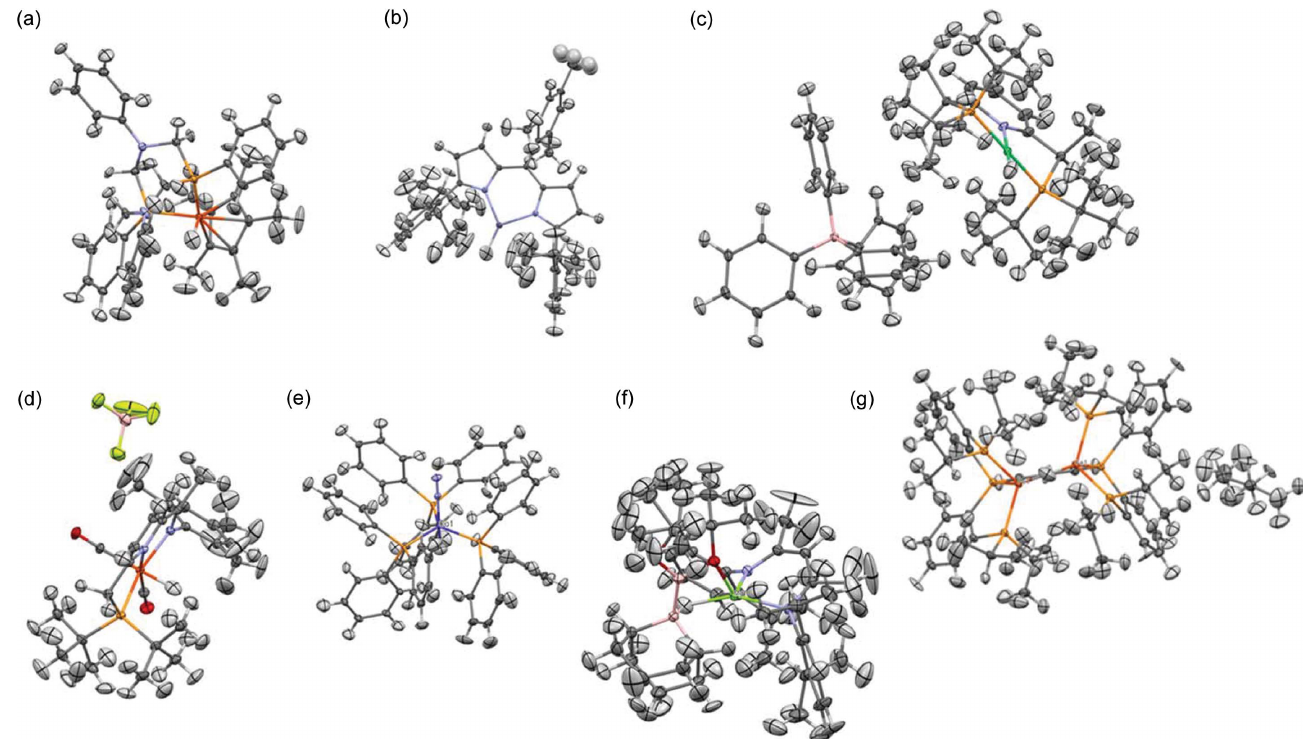
Figure 16 Structures of the metal–organic compounds refined using HAR with fragmentation: ( a ) AHUKIZ, ( b ) LOKPOT, ( c ) MOVPIZ, ( d ) MUHBOI, ( e ) PPHCHN11, ( f ) QEPCOG, ( g )